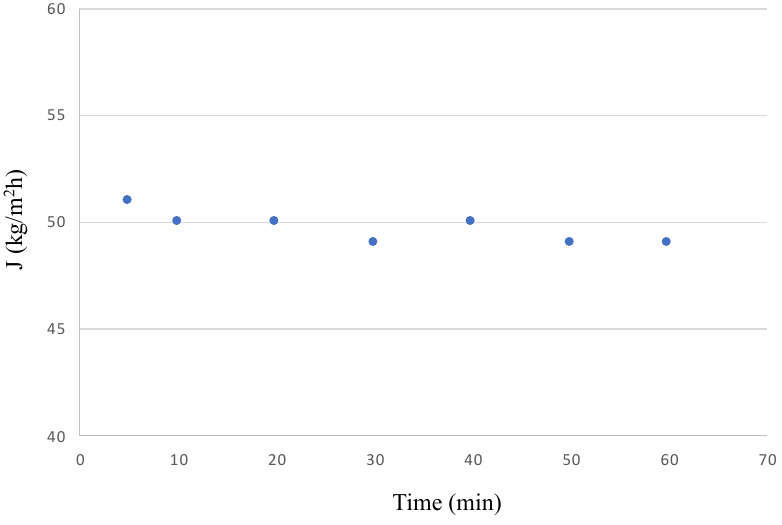
Figure 11. DCMD tests. The trend of the flux with time. Feed: 80 g/L; 80 °C.